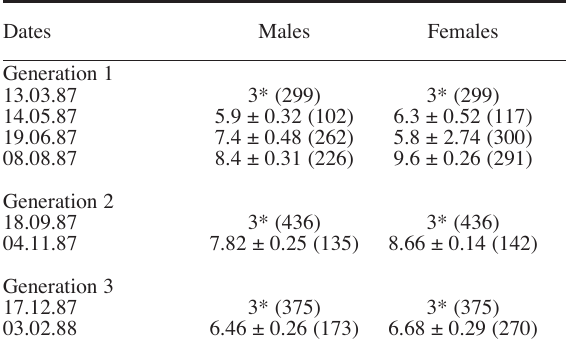
F IG . 7. – Relative abundance of the different developmental stages of Neomysis americana during the study period, with indication of the start of each new generation. (J) juveniles, (M) males, (F) females, GF (gravid females), G (generation). T ABLE 1. – Mean size (± SD) of males and females of the three annual generations of Neomysis americana . * Size of juveniles of each generation. In brackets: number of individuals